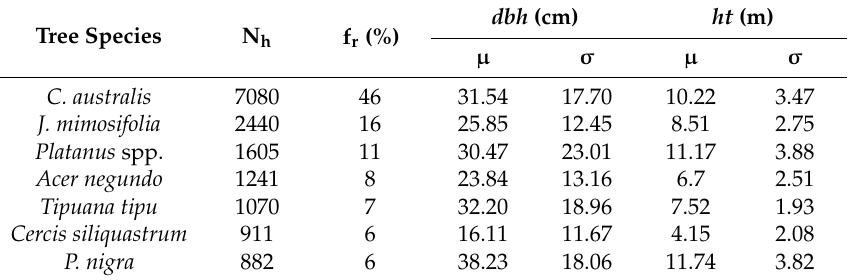
Table 2. Number of individuals (N h ) for the tree species selected for this study and their relative frequency (f r ) in a set of 15,229 individuals. Mean and standard deviation for diameter at breast height ( dbh ) and height ( ht ) for each tree species.